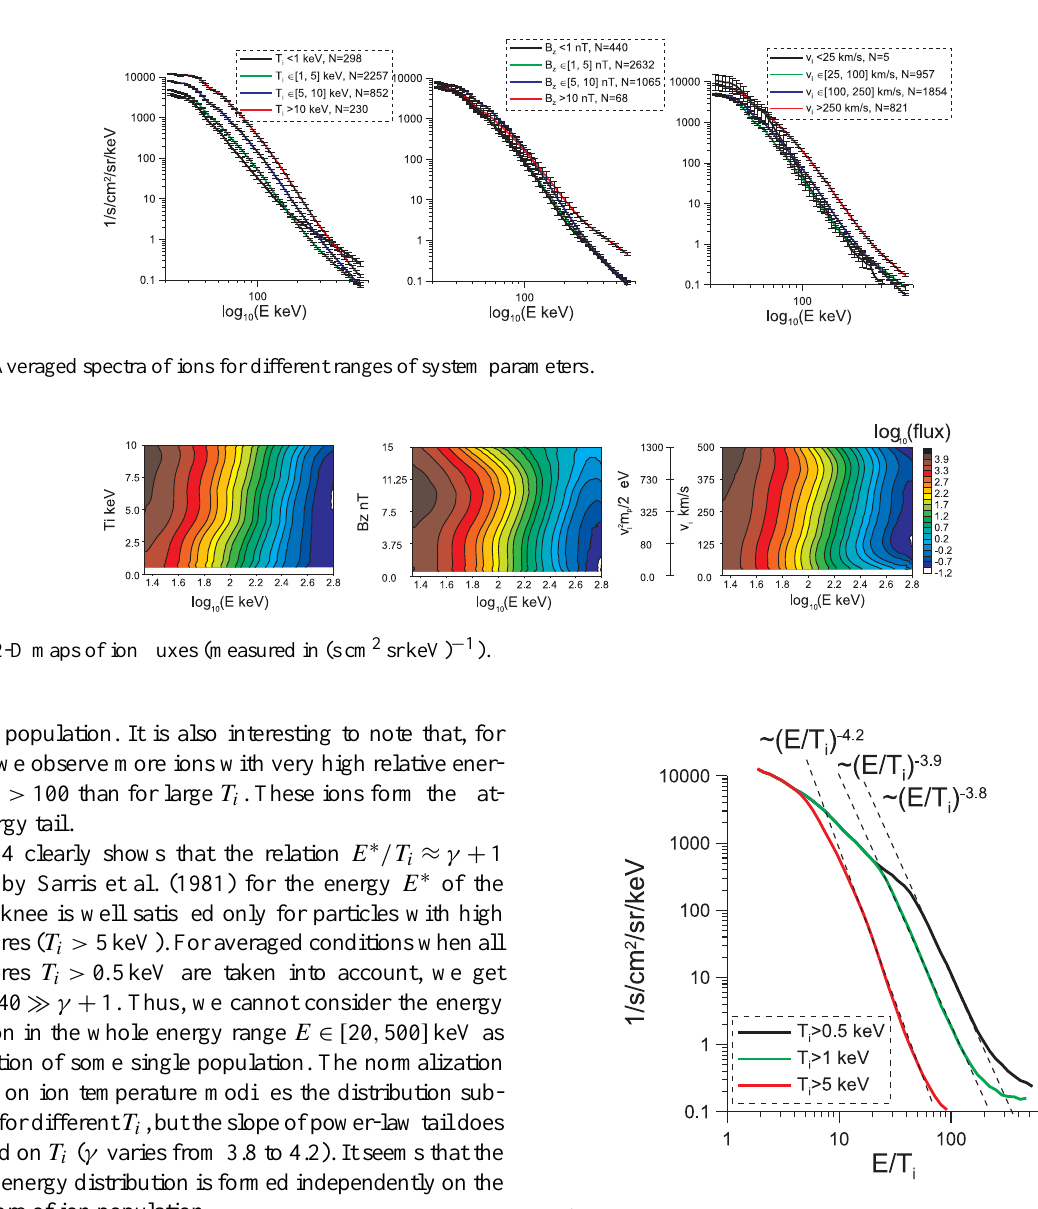
Figure 4. Averaged ion spectrum with the energy normalized on the ion temperature T i